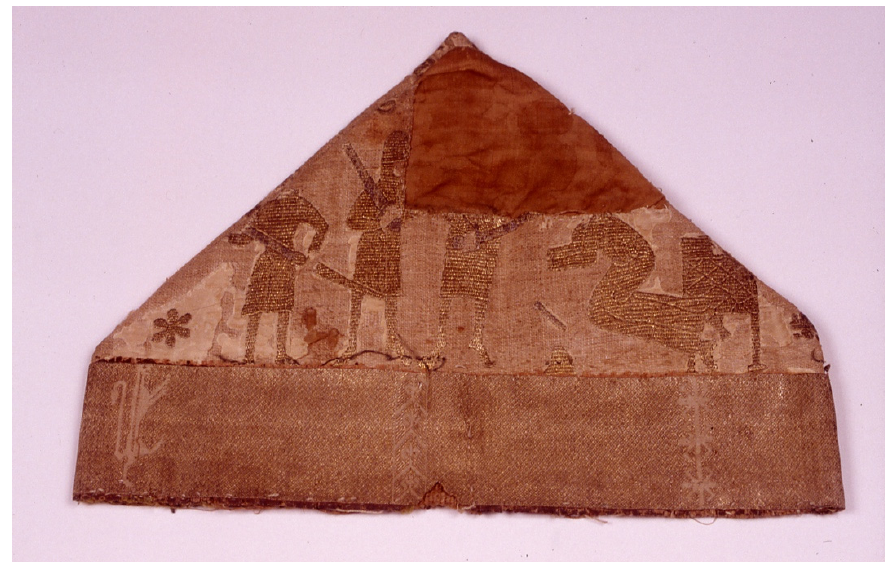
Figure 5. Sens Mitre, front face with the martyrdom of Becket, early 13th century. Musées de Sens, France. © Musées de Sens—E. Berry.